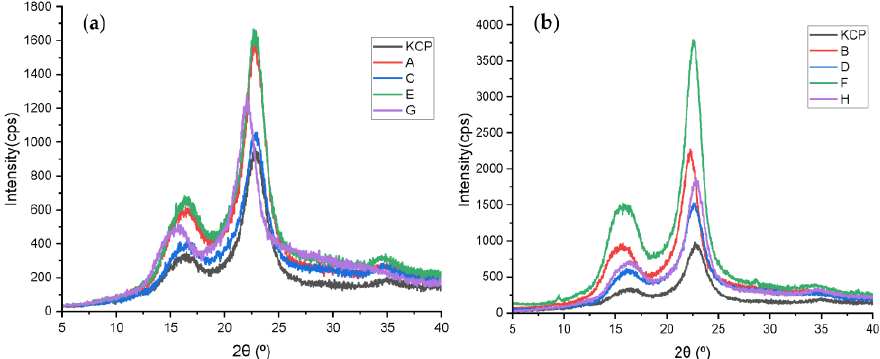
Figure 6. Diffractograms of the validation samples: ( a ) without ultrasonic dispersion treatment and ( b ) with ultrasonic dispersion